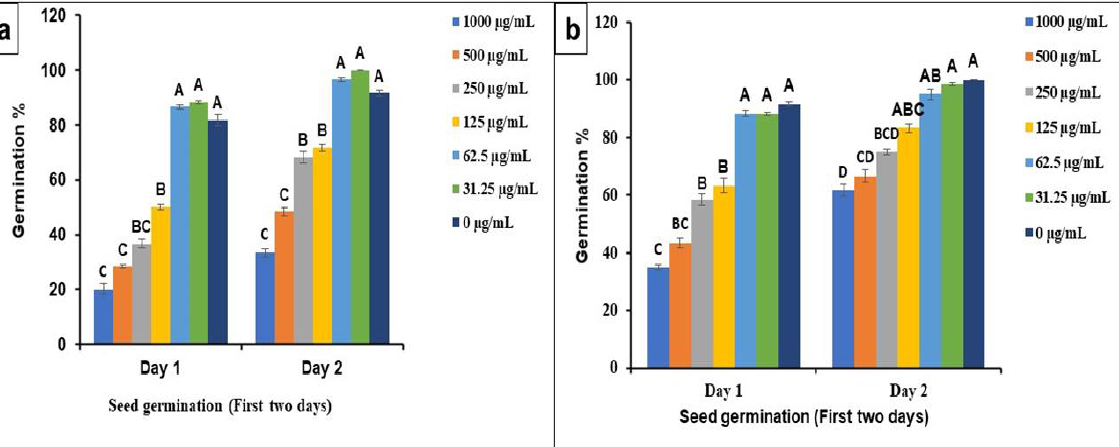
Figure 8. Phytotoxicity and stimulatory effect of BPL extract and BPL-based NiONPs on relative germination rate (RGR) of seed during first two days (D1 and D2): ( a ) rate of germination of radish seeds against various concentrations (1000 – 31.25 µg/mL) of BPL-NiONPs; ( b ) rate of germination of radish seeds against various concentrations (1000 – 31.25 µg/mL) of BPL extract. The obtained data are presented as mean ± standard deviation ( n = 3). Letters specify a significant difference ( p < 0.05) between control and BPL-NiONP-treated samples.